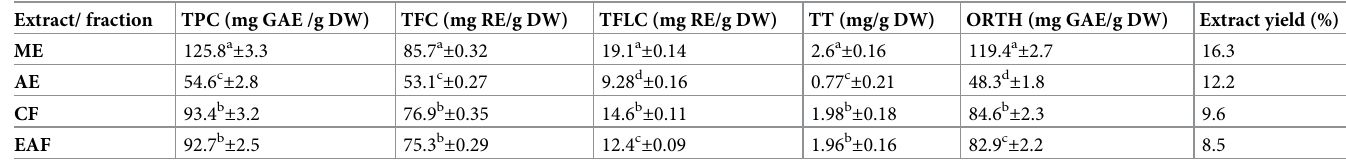
TPC, total phenolic content; TFC, total flavonoid content; TFLC, total flavonol content; TT, total tannin; ORTH, Ortho -diphenols Data represent mean ± standard deviation (SD) of three biological replicates. All mean values in the same column with different letters are significantly different from each other at P < 0.05.